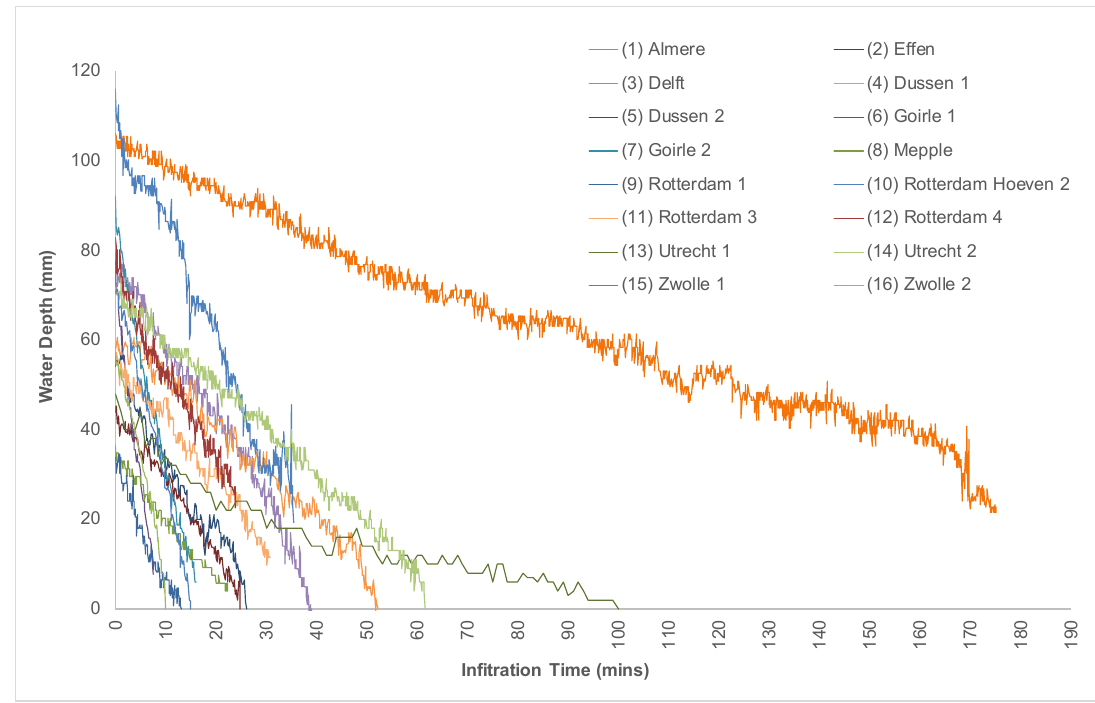
Figure 8. Infiltration curves for each of the 16 test sites with location numbers in Figure 3b. Table 2. FSIT results. Simple linear regression analysis was used to generate lines of best fit for the transducer readings from each site. The equations of the linear regression lines were then used to calculate the average Figure 3 Location infiltration rate in mm/h for each test site (Table 2). Some of these lines were extrapolated past the x- axis to achieve the required 60 min duration which explains the negative depth values in Table 2.